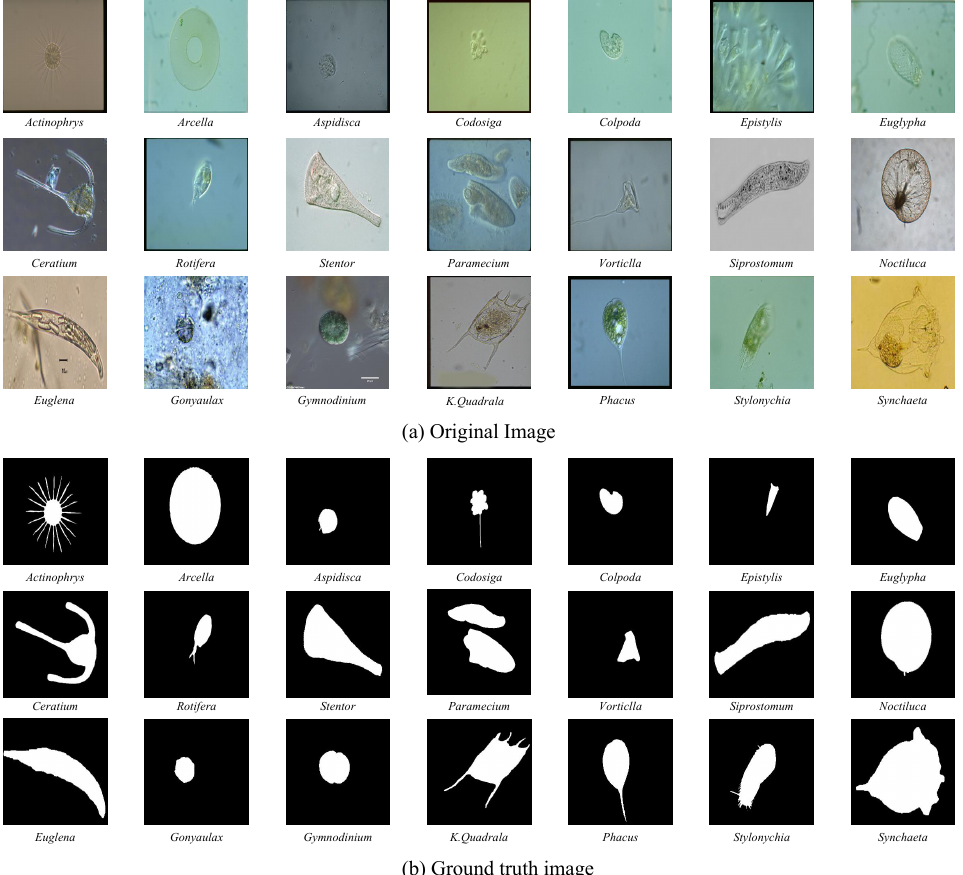
Pixel-Level Data Preprocessing